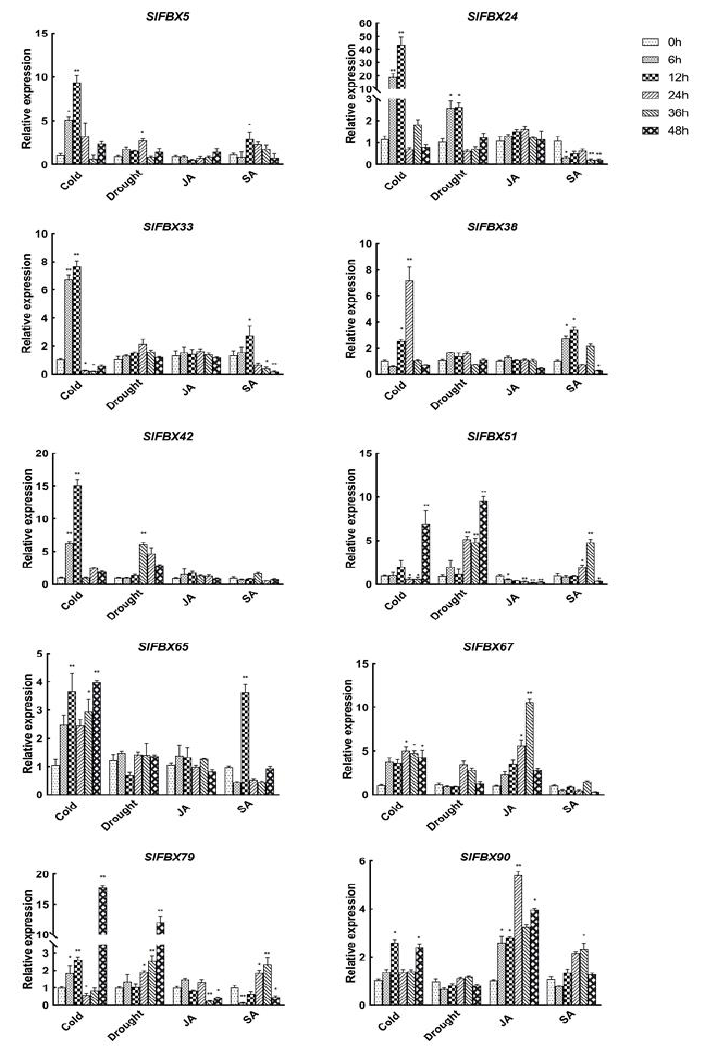
Figure 7. Relative expression analysis of 10 genes in the SlFBX gene family under cold stress, drought stress, JA treatment and SA treatment in tomato. ANOVA was used to test significance ( p < 0.05 indicates significant difference, indicated by *; p < 0.001 indicates high significance, indicated by **).